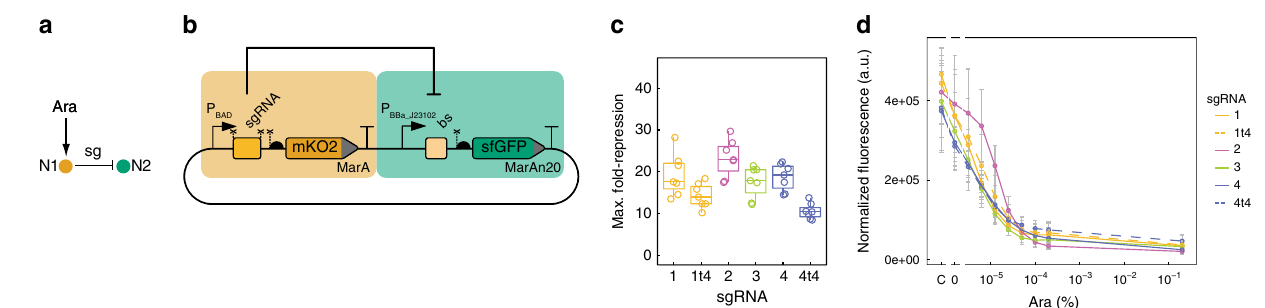
Fig. 1 Assessment of CRISPRi repression through a 2-node NOT logic circuit. a Schematic representation of the circuit architecture, where the fi rst node (N1) is induced by Ara and in turn produces a sgRNA (sg) that represses the second node (N2). b Details of the circuit design. In addition, AraC, dCas9, and Csy4 are constitutively expressed. Bent arrows: promoters; squares: sgRNA binding sites; rectangles: sgRNAs; crosses: csy4 recognition sites; semicircles: RBSs; pointed rectangles: reporter genes with degradation tags; and T-s: transcriptional terminators. c Maximum fold-repression of N2 achieved by four different sgRNAs, calculated as the GFP fl uorescence of a fully-induced (0.2% Ara) circuit relative to a control lacking the sgRNA. Truncated variants of sgRNA-1 and -4 lacking the four 5 ′ nucleotides (t4) were also assessed. Data correspond to seven biological replicates. Boxes represent quartiles Q1 (box lower limit), Q2 (i.e., median, internal line) and Q3 (box upper limit); whiskers comprise data points that are no more than 1.5× IQR (inter-quartile region, i.e., the length of the box) away from the box. d Dose-response curves for the NOT circuits operating through sgRNA-1 to -4 (including t4 variants of sgRNA-1 and -4). The response (GFP fl uorescence) of all four circuits can be modulated by adjusting the input dose (Ara). The controls lacking the sgRNAs (C) showcase some level of P BAD leakiness in the NOT circuits that results in weak repression even in the absence of Ara (0). Mean and s.d. of three biological replicates. Source data are provided as a Source Data fi